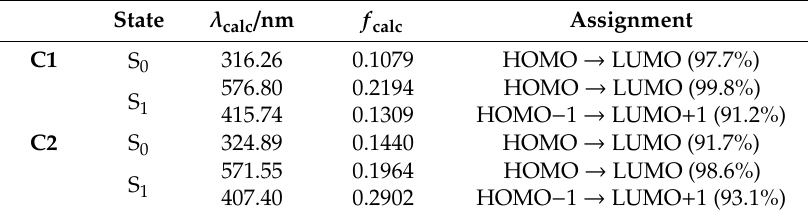
Figure 4. Frontier molecular orbitals of C1 and C2 in their ground states (S 0 ) and first-excited singlet states (S 1 ) and their relative energies calculated by DFT (isovalue = 0.04 a.u.). The transition energy (in nm) was calculated at the TD-B3LYP / 6-31G(d) level of theory. Table 2. Major low-energy electronic transitions in C1 and C2 involving their ground states (S 0 ) and first-excited singlet states (S 1 ) calculated at the TD-B3LYP / 6-31G(d) level of theory. 1